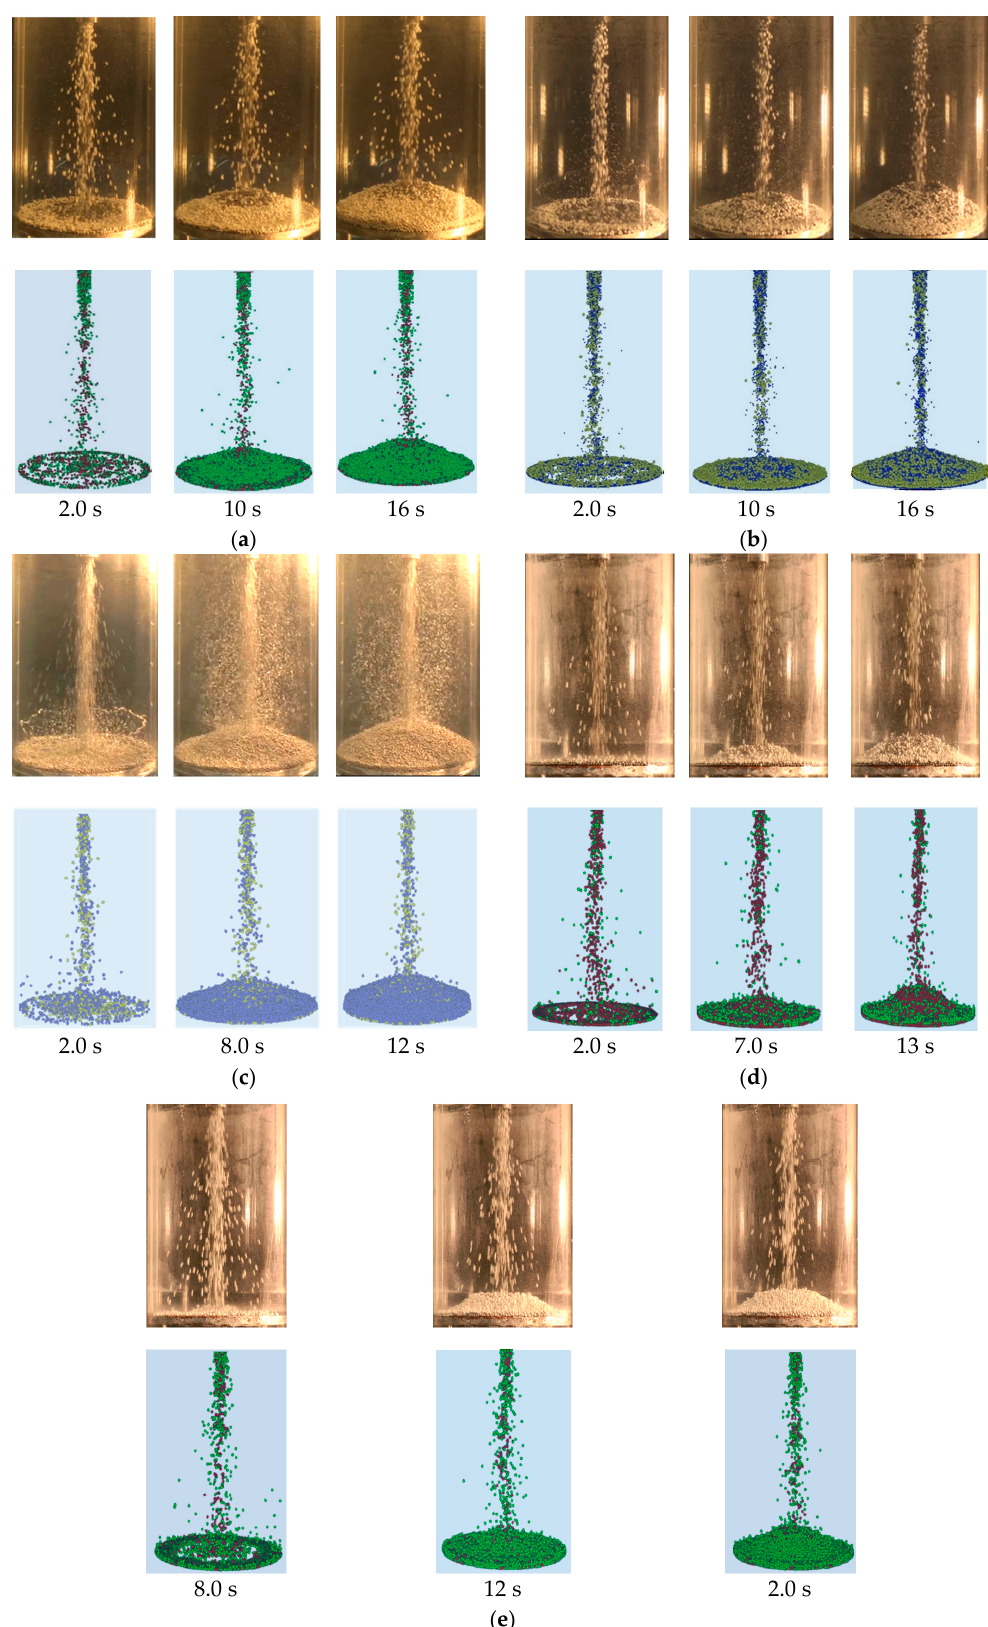
Figure 5. Falling and sedimentation behaviors of mixed particles with different properties: ( a ) Case M1; ( b ) Case M2; ( c ) Case M3; ( d ) Case M4; ( e ) Case M5.